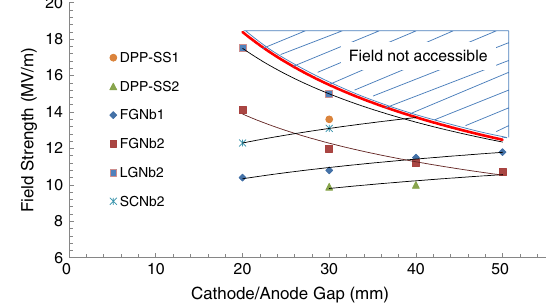
FIG. 4. The field strength at which each electrode exhibited 100 pA of field emission as a function of anode/cathode gap. For LGNb1 and SCNb1, the field exceeded values denoted by the red line for all gaps. For LGNb2, SCN2, and DPP-SS1, the field exceeded values above the red line at 40 and 50 mm gaps. Black lines represent simple power-law fits to aid the